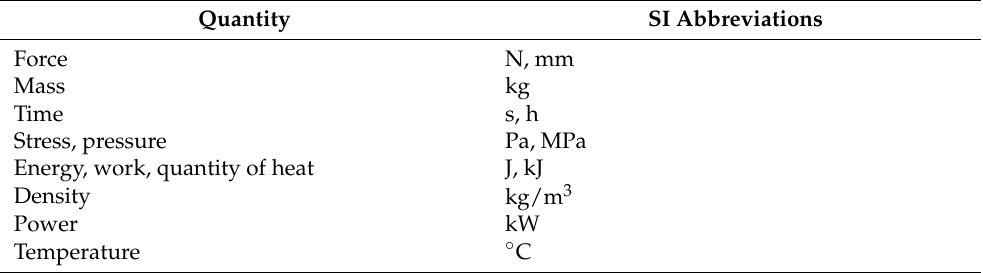
Table 2. Description of the SI